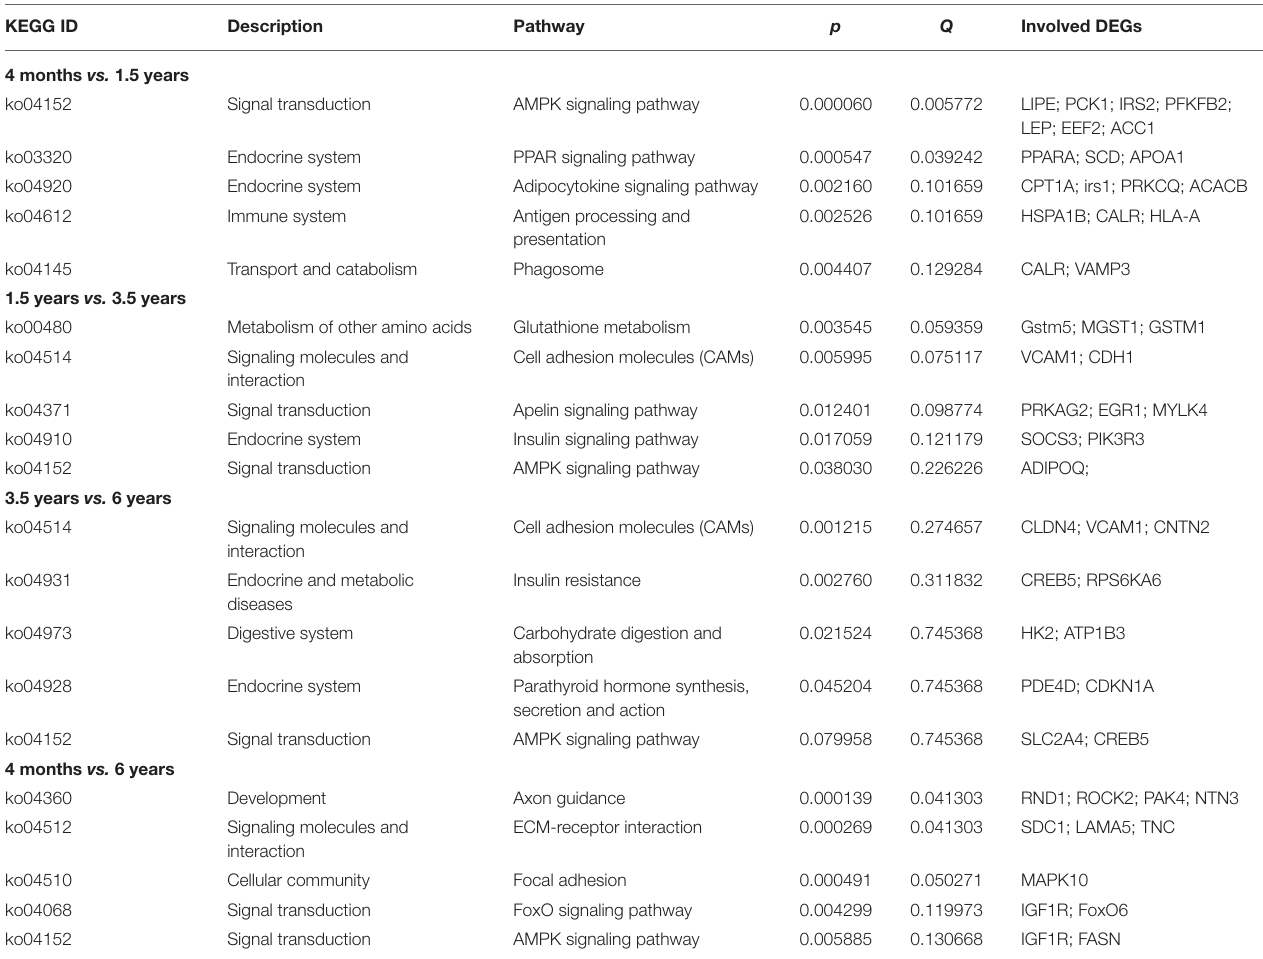
TABLE 2 | The significant KEGG enrichment results of